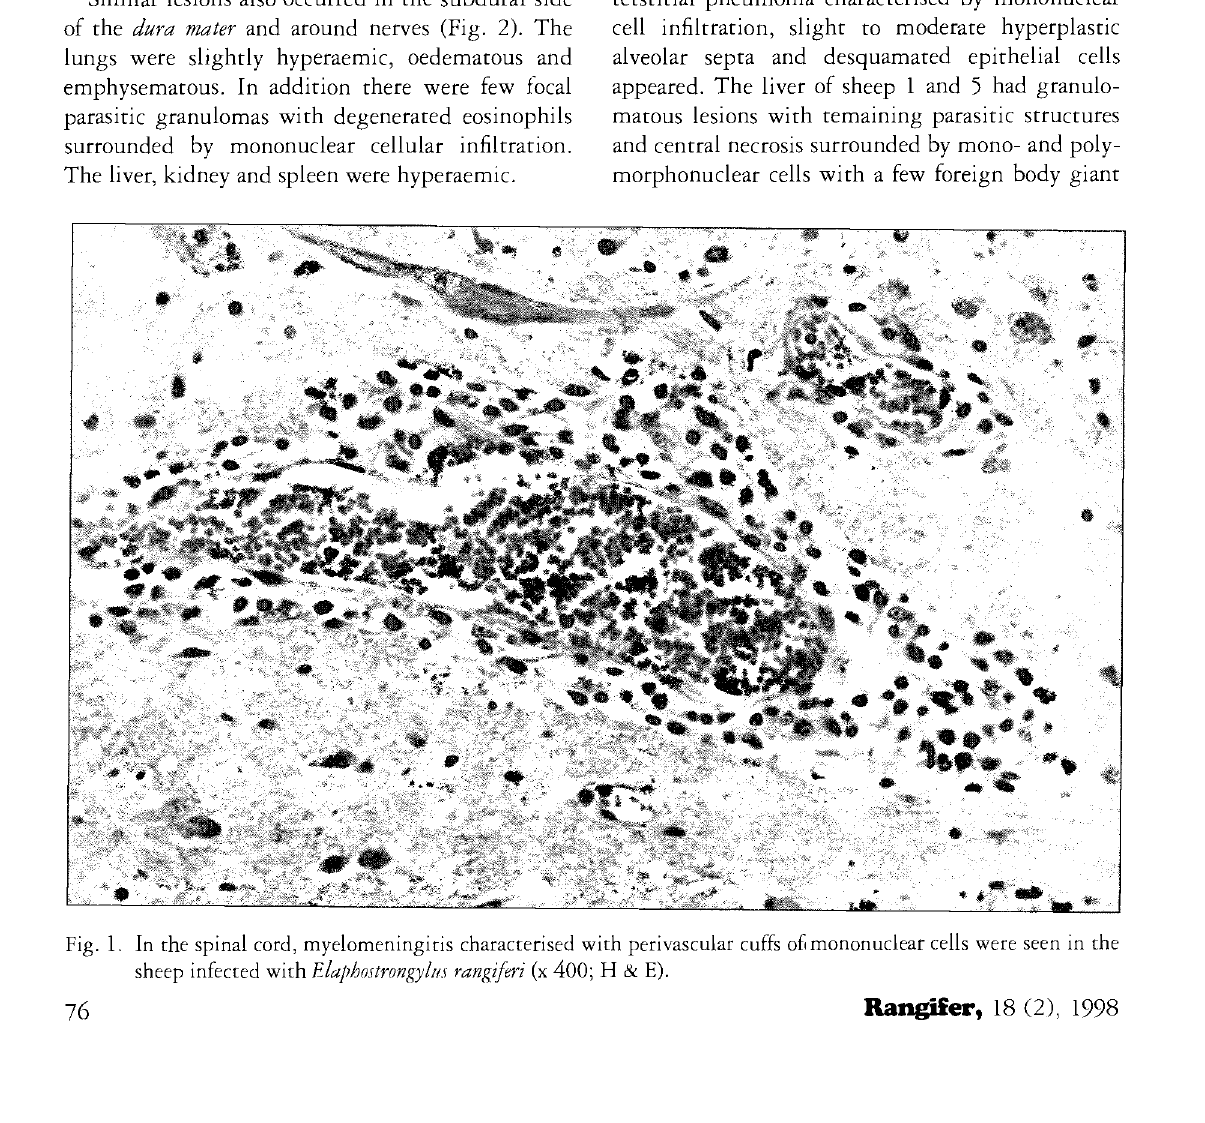
Fig. 1. In the spinal cord, myelomeningitis characterised with perivascular cuffs of mononuclear cells were seen in the sheep infected with Elaphostrongyhis rangifert (x 400; H &